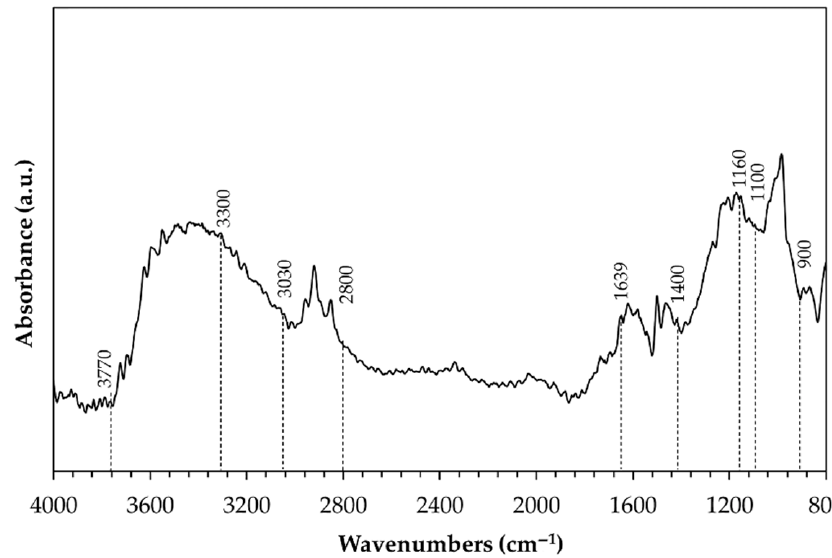
Figure 3. X-ray diffraction patterns recorded on the surface of pins before wear tests: ( a ) HA_50; ( b ) GP_100.